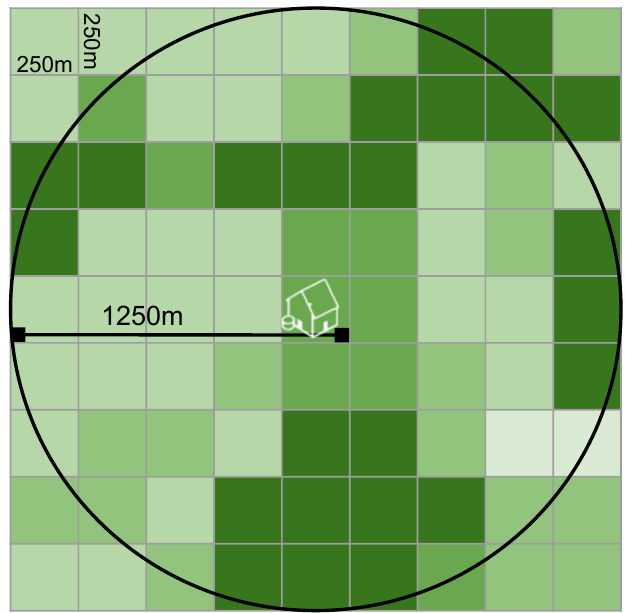
Figure 1. Schematic of residential greenness measurement, which was completed by taking the average of NDVI in a 5-pixel (1250 m) radius surrounding and including the home in the three seasons preceding